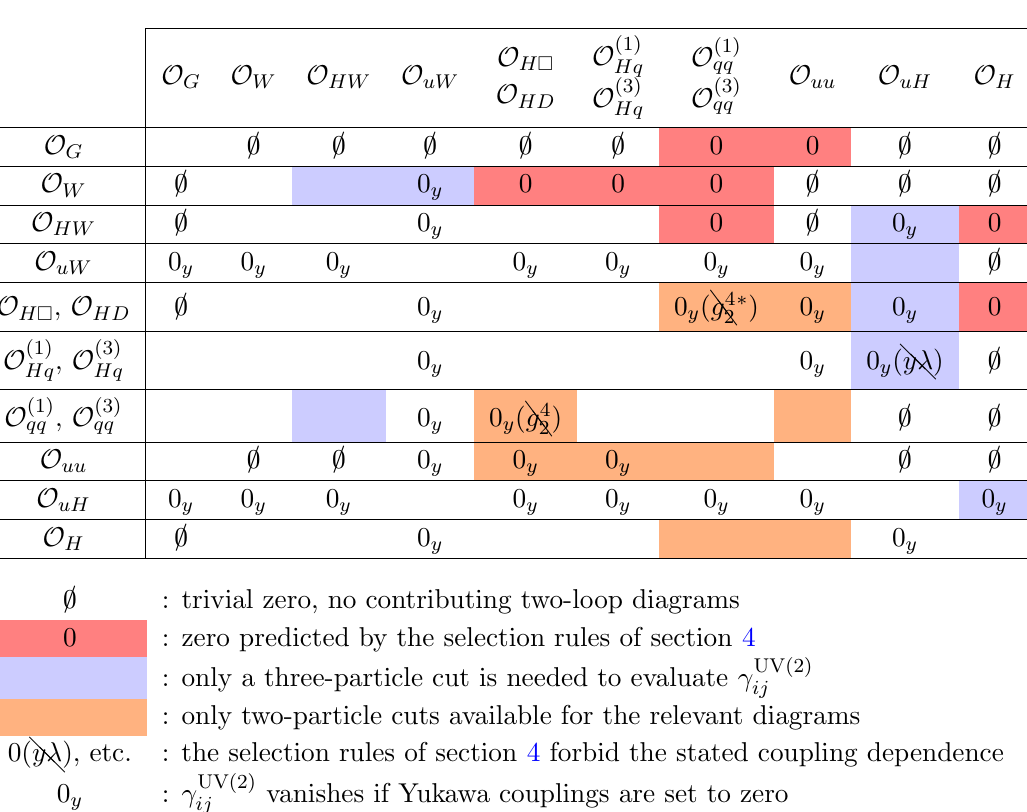
Table 6 . Predictions for the zeros and coupling dependences of a representative selection of the SMEFT two-loop anomalous-dimension matrix, (cid:13) UV(2) . The notation for the operator labels follows ij (cid:3) ) vanishes using the appropriate that of [4{6]. The g 4 dependence of the entry labeled 0 y ( SS g 4 2 2 counterterms at one loop. The operators labeling the rows are renormalized by the operators labeling the